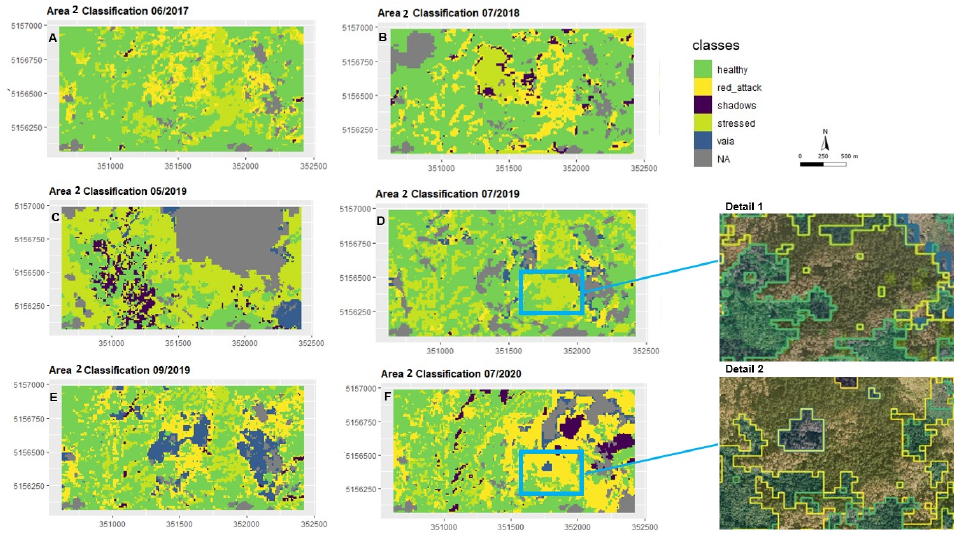
Figure 10. Classification maps of cropped area 2 (June 2017 ( A ), July 2018 ( B ) , May 2019 ( C ), July 2019 ( D ), September 2019 ( E ) and July 2020 ( F )) according to forest cover classes (“healthy”, “red_attack”, “shadows”, “stressed” and “vaia”) and details showing orthophotos from 2020 with a spatial resolution of 10 cm provided by IRDAT. The orthophotos were overlayed by classification products in the form of polygons and transparent rasters. Reference system: WGS84-UTM33N. The overall accuracies of all supervised classifications reported varied between 0.8 and 1, with kappa values between 0.7 and 1 (Appendix A Table A1). The variable im- portance slightly varied between the different classification algorithms, of which ANN and RF were found to be the most suitable for forest health detection and forest-cover change detection. The most important variables for ANN classification were the Red-Edge bands (B06 and B07) and the green band (B03), as well as vegetation indices containing Red-Edge bands, such as NDREI1, NDREI2 and REIP, as well as TCW (Figure 11B,D; Ap- pendix A Figures A1B,D and A2B,D). The RF algorithm mainly relied on the Red-Edge band (B06), the NIR band (B08) and the NDRS index containing the red (B04) and SWIR